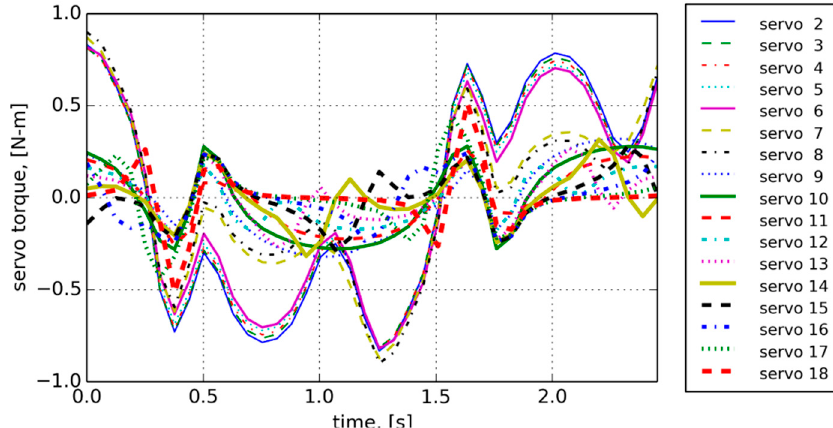
Figure 6. Generated servo torques vs. time.